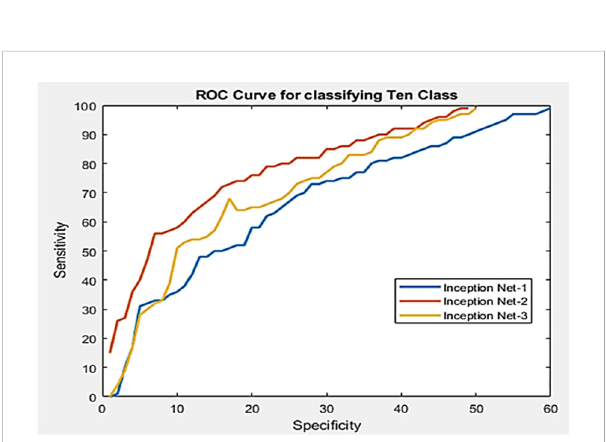
FIGURE 8 An example of performance comparison between three models using the ROC curve (Shoaib et al.,